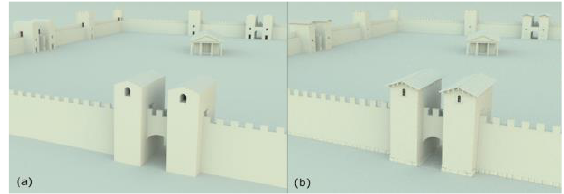
Figure 6. Overview of LOD - Visualization of castellum structure (a); Detailed visualization of castellum